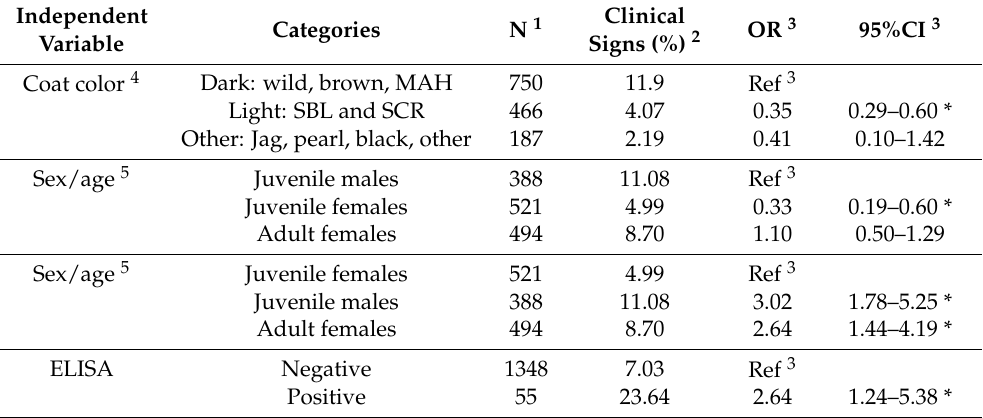
Table 3. The percentage of minks with clinical signs on the seven extensively sampled farms, with for each of the variables with a significant association with clinical signs, i.e., coat color, sex/age, and a positive ELISA test result, the odds ratio (OR) and 95% confidence interval (95% CI) based on the univariable logistic regression